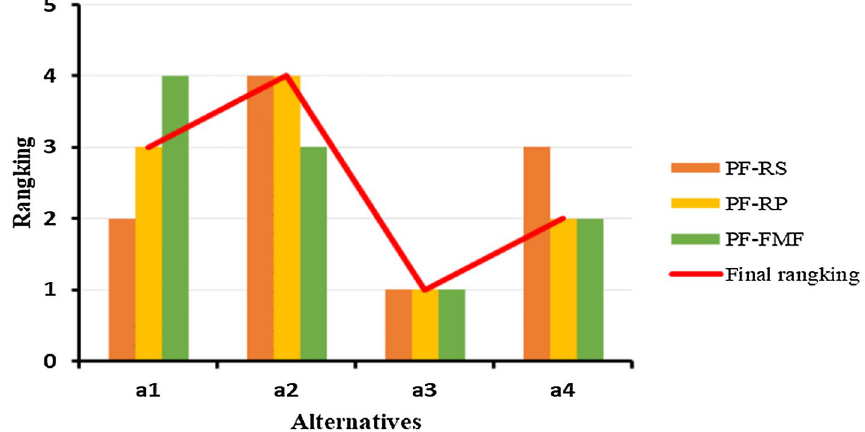
Fig. 3 Final ranking of the alternatives based on the Borda scores